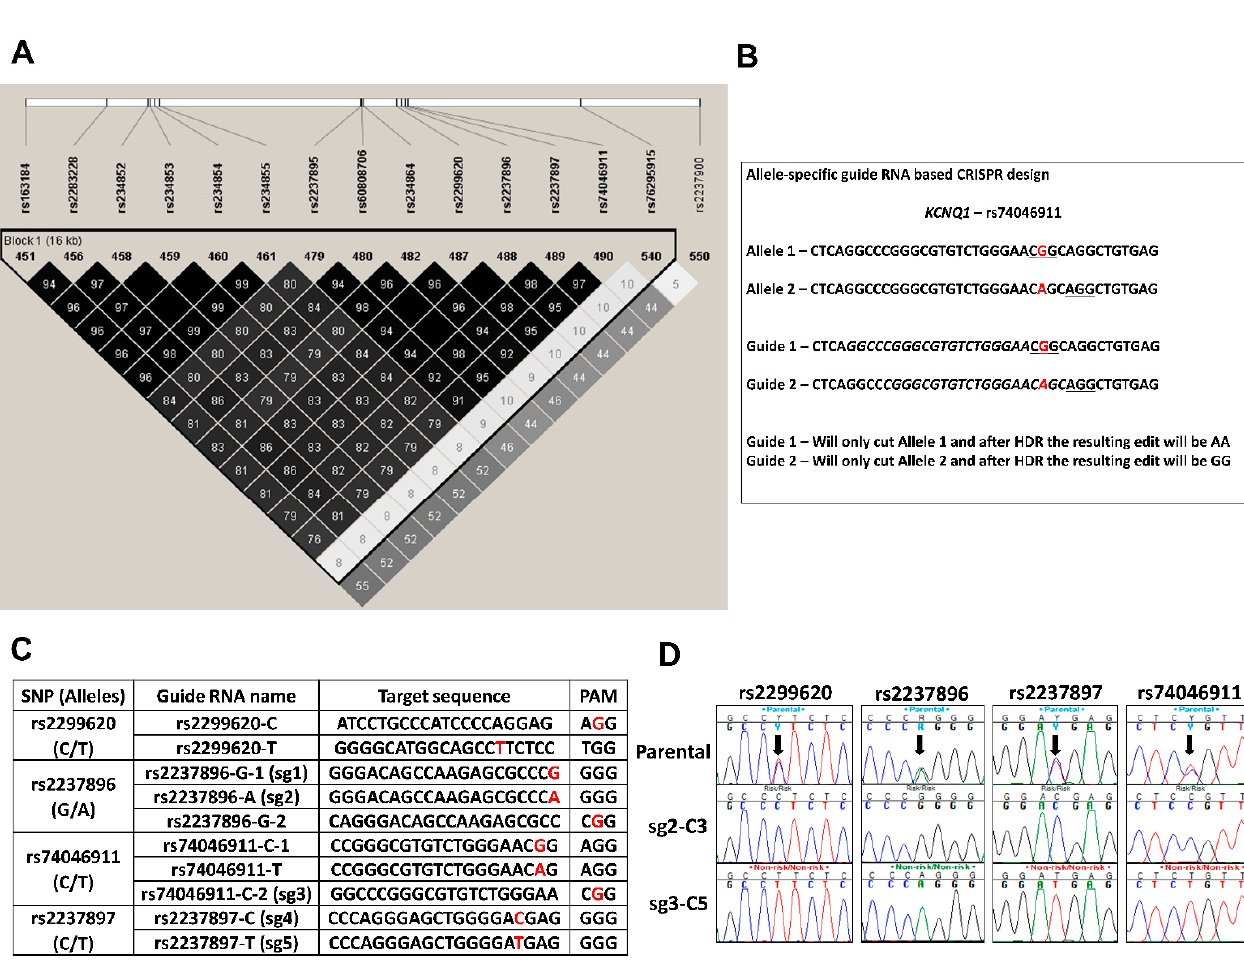
Figure 2. Experimental design and generation of genome-edited isogenic hiPSCs with edits at multiple SNPs. ( A ). Linkage disequilibrium at the T2D associated KCNQ1 locus in Southwestern American Indians. Selected SNPs in strong LD with the T2D associated lead SNP (rs2299620) at the KCNQ1 locus identified using whole-genome sequencing data from 296 American Indian subjects. ( B ). A representative example showing allele-specific guide RNA design to target the T2D associated rs74046911 SNP (highlighted in red) at the KCNQ1 locus. DNA repair following CRIPSR will lead to loss of heterozygosity at nearby SNPs as well. Red – SNP, underline – PAM site, Italics – 20 bp target sequence upstream of the PAM site. (C). Allele-specific Guide RNA design showing the targeted SNPs, target sequence (protospacer) and the PAM site. SNP site is indicated in red. ( D ). Generation of isogenic cells lines using allele specific CRISPR sgRNAs. Chromatograms showing successful edits at the four putative functional SNPs (arrows) from two representative clonal cell lines compared to the parental cell line.